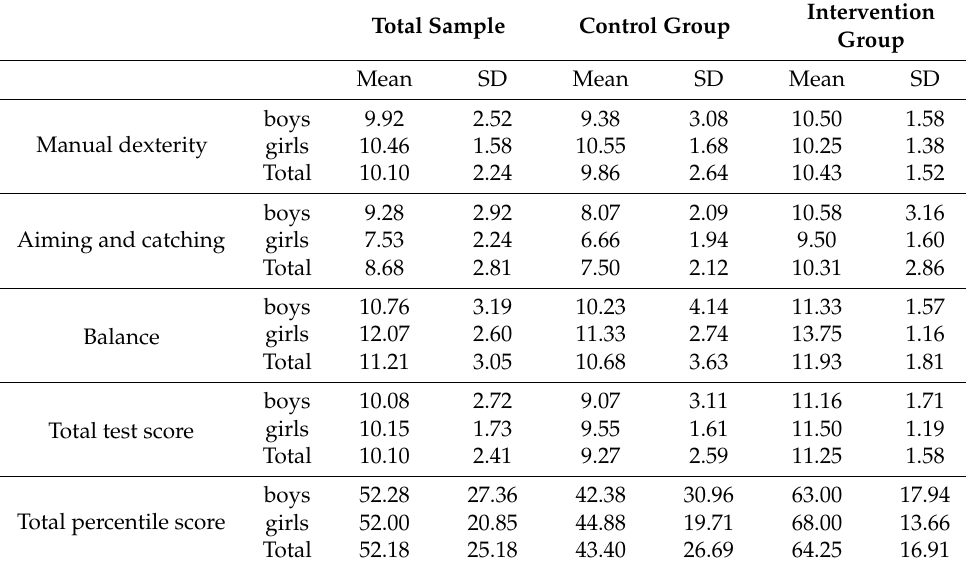
Table 3. Results of MABC-2 test after intervention based on the type of group and gender. Intervention Total Sample Control Group